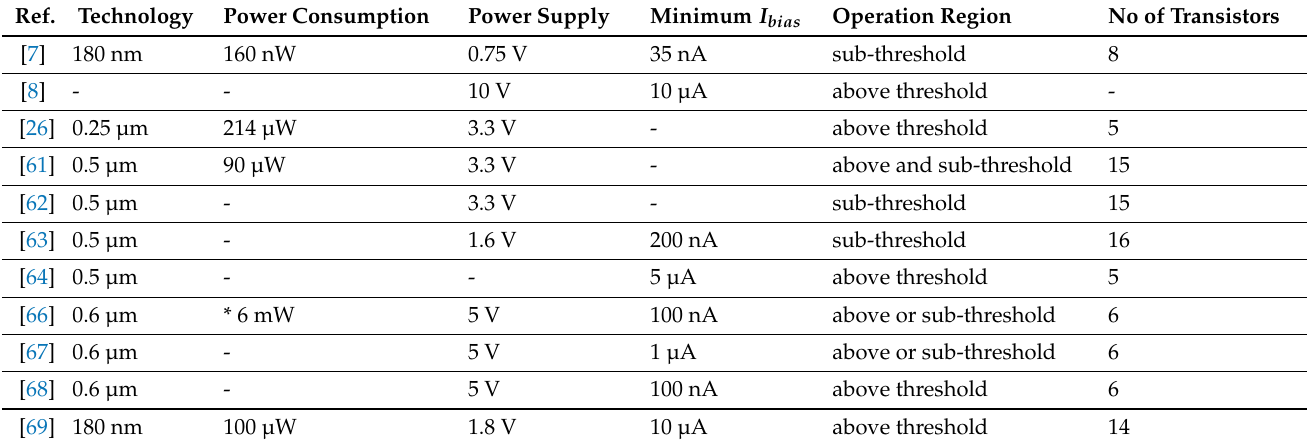
Table 3. Gaussian Function Circuits using Floating Gate Transistors. * For the entire system. Ref.